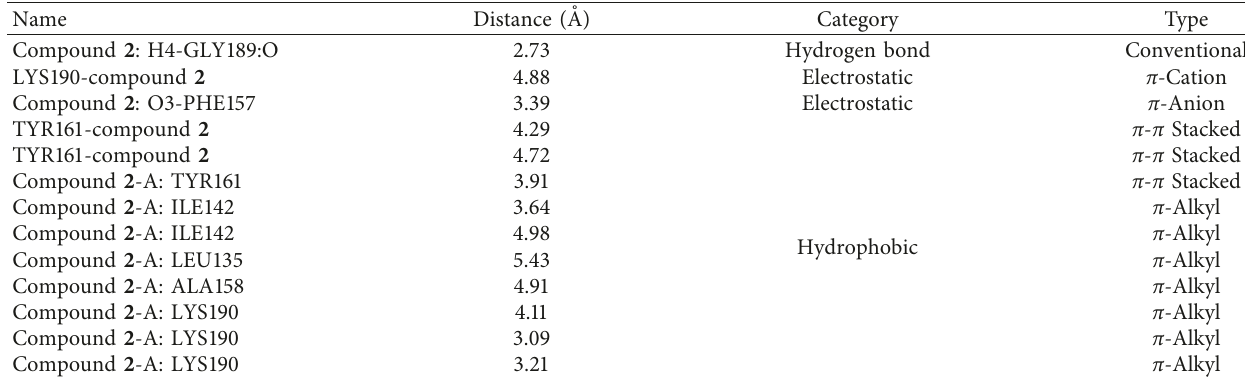
Table 5: Noncovalent interactions of compound 2 with the HSA binding site